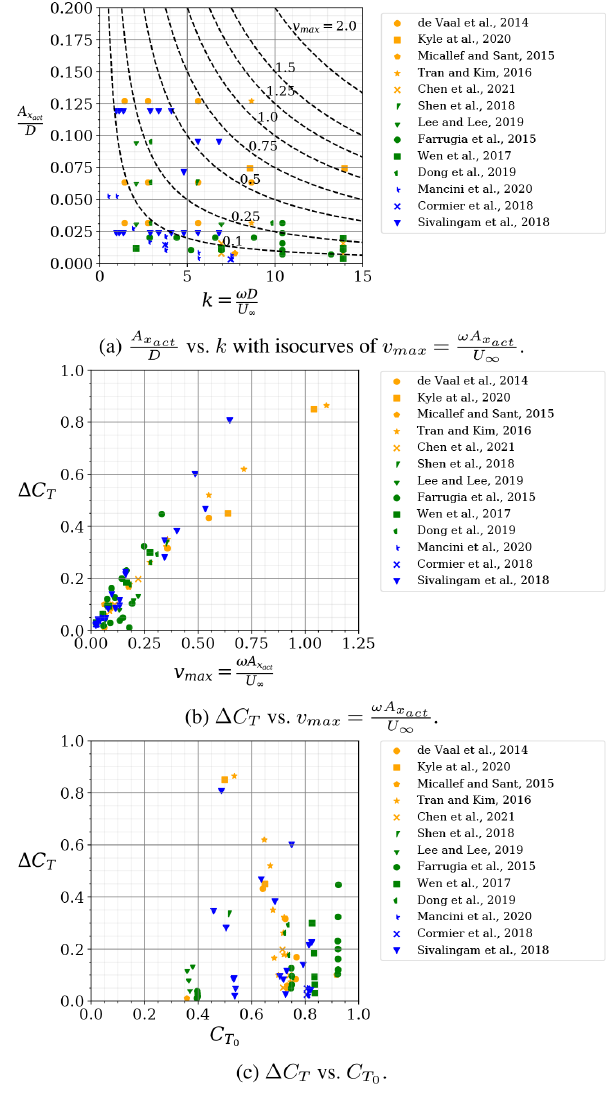
Figure 1. Survey of the experimental and numerical study cases in the work of de Vaal et al. (2014), Kyle et al. (2020), Mancini et al. (2020), Micallef and Sant (2015), Tran and Kim (2016), Chen et al. (2021), Sivalingam et al. (2018), Shen et al. (2018), Lee and Lee (2019), Farrugia et al. (2016), Wen et al. (2017), Cormier et al. (2018), and Dong et al. (2019). The study cases are organized ac- A x act cording to the key operational indicators: vs. k with isocurves D ωA x act (b) and (cid:49)C T vs. C T (c) . Or- of v max (a) , (cid:49)C T vs. v max = U ∞ 0 ange symbols represent Eulerian Navier–Stokes simulations (com- monly referred to as CFD), green symbols represent Lagrangian vortex models and blue symbols represent experiments (some also including